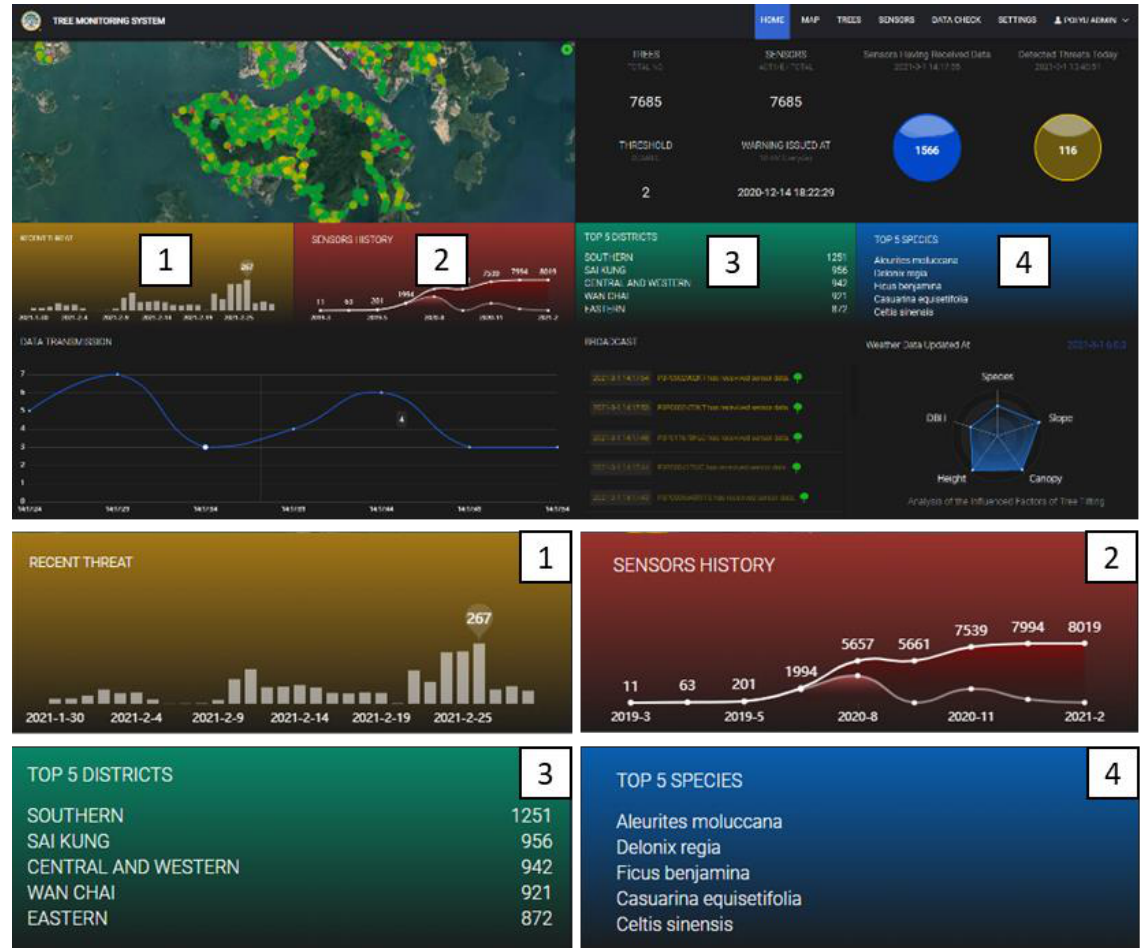
Figure 8. The first generation of dashboard development to demonstrate sensor condition, tree locations and attributes, weather, and location information. (1) Number of threatened trees in Hong Kong at different time periods; (2) Number of sensors being installed in Hong Kong at different time periods; (3) Top 5 districts in Hong Kong; (4) Top 5 tree species in Hong Kong